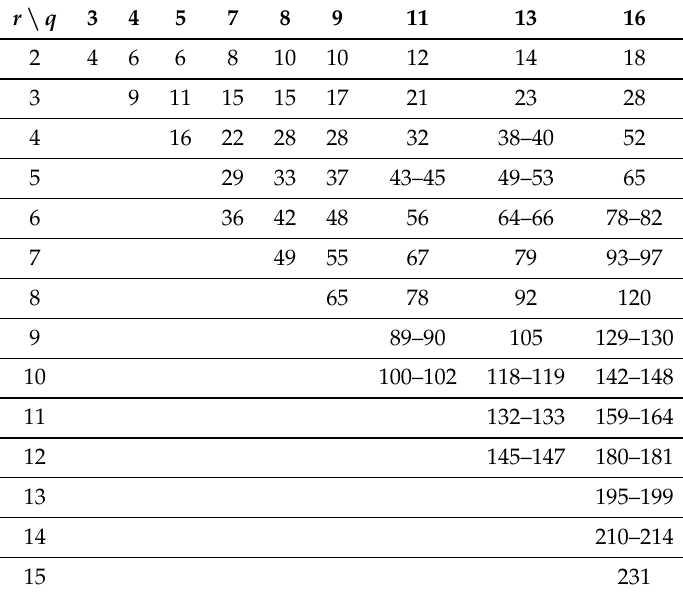
Table 1. The known values and bounds on m r ( 2, q ) , 3 ≤ q ≤ 16.